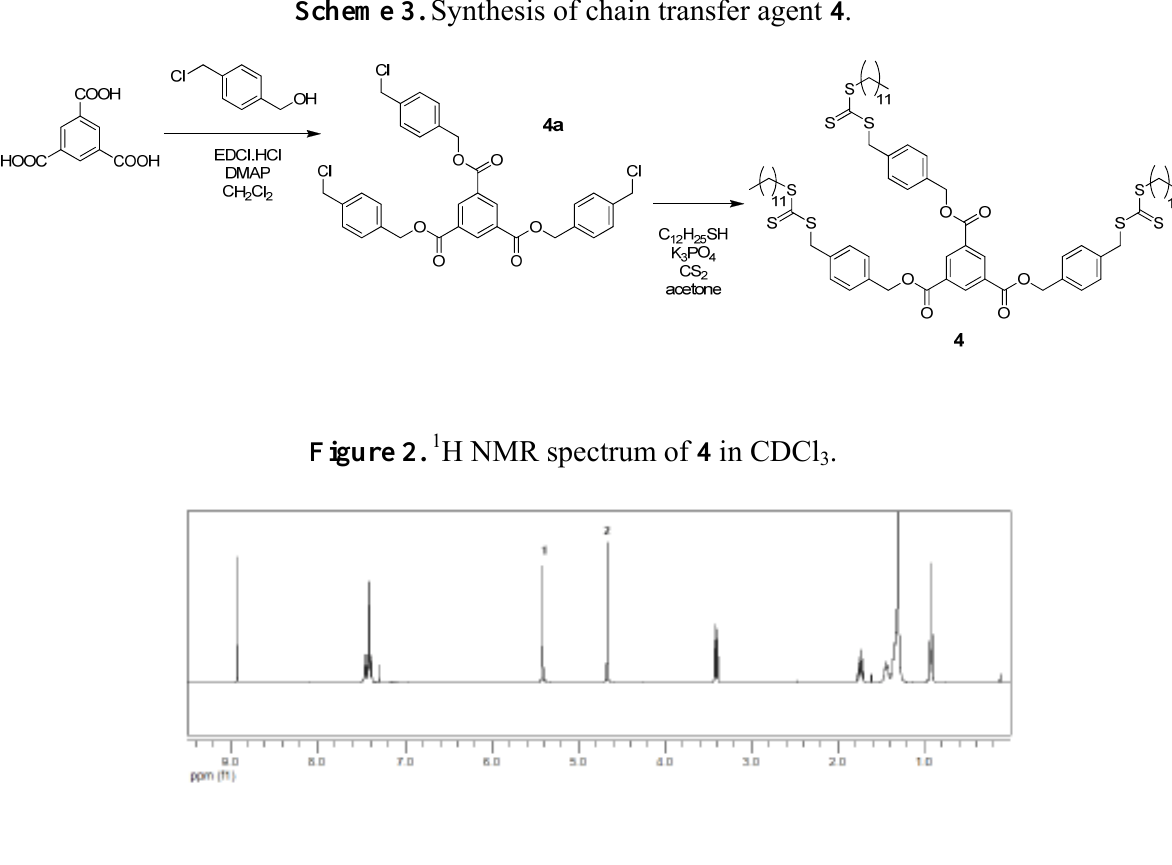
Scheme 3. Synthesis of chain transfer agent 4 .